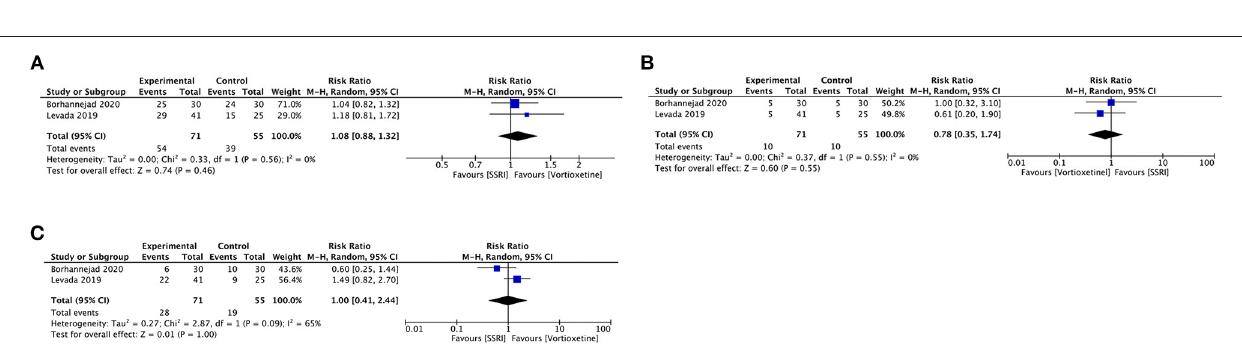
FIGURE 7 | Forest plot of comparison on vortioxetine vs. SSRIs (A) Response, (B) remission, and (C)